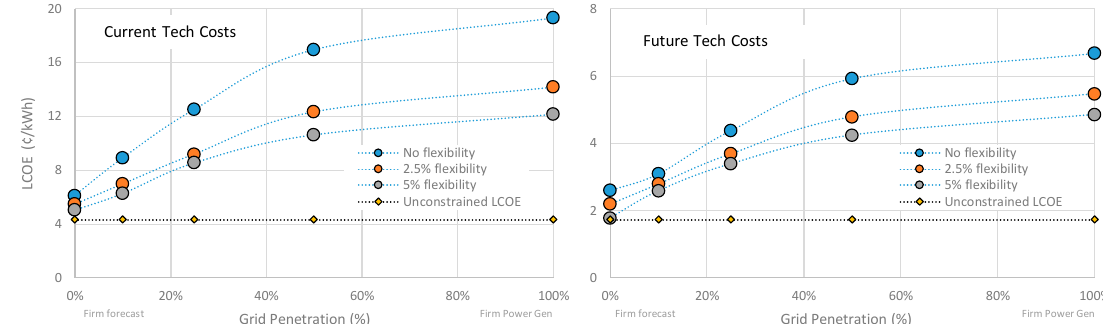
Figure 8. The evolution of firm PV generation LCOE from low penetration firm forecast requirements to high penetration firm power generation requirements, compared to unconstrained PV generation LCOE, at current ( left ) and future ( right ) technology costs. Note: these illustrative plots are for the entire NYISO.